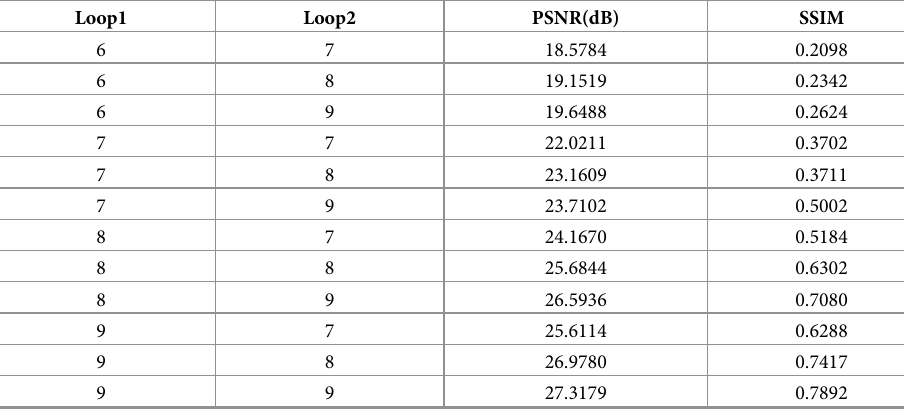
Table 4. Compression with different